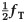
Amplitude at the subharmonic frequency, 12fT.For microbubbles insonified at a frequency of 0.5 MHz and P_ of 25 kPa (A), frequency of 0.5 MHz and P_ of 50 kPa (B), and frequency of 1 MHz and P_ of 50 kPa (C). For figure legend, see the rightmost column of Fig 2 and Fig 3. A value of 0 indicates no subharmonic was present.